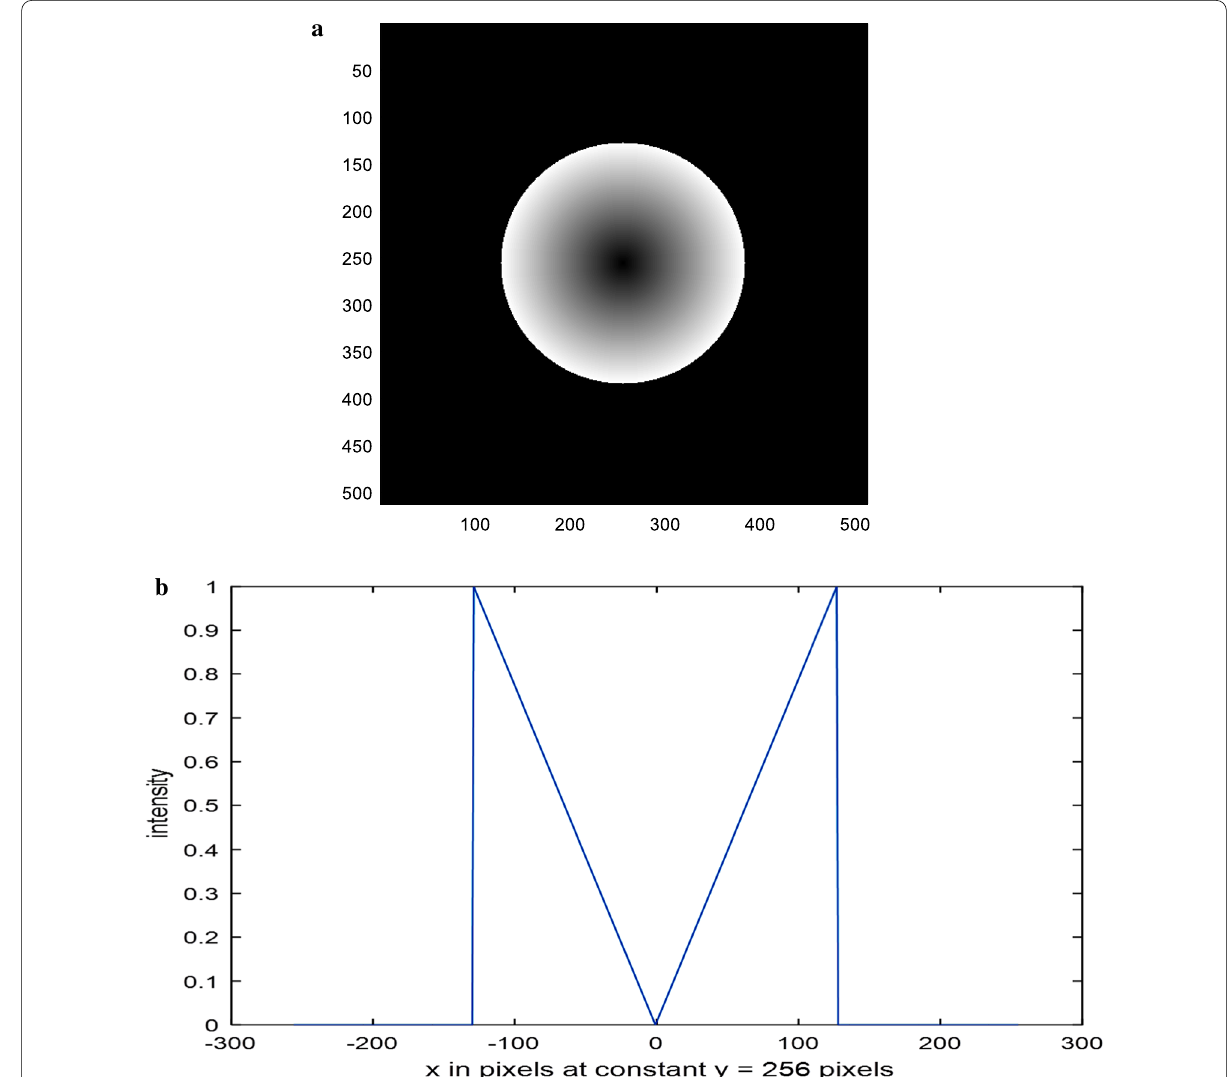
Fig. 2 a An image of a linearly distributed aperture. The matrix dimensions have 512 The intensity plot of the linearly distributed aperture shown in the ( a ) at the center of the aperture at constant y